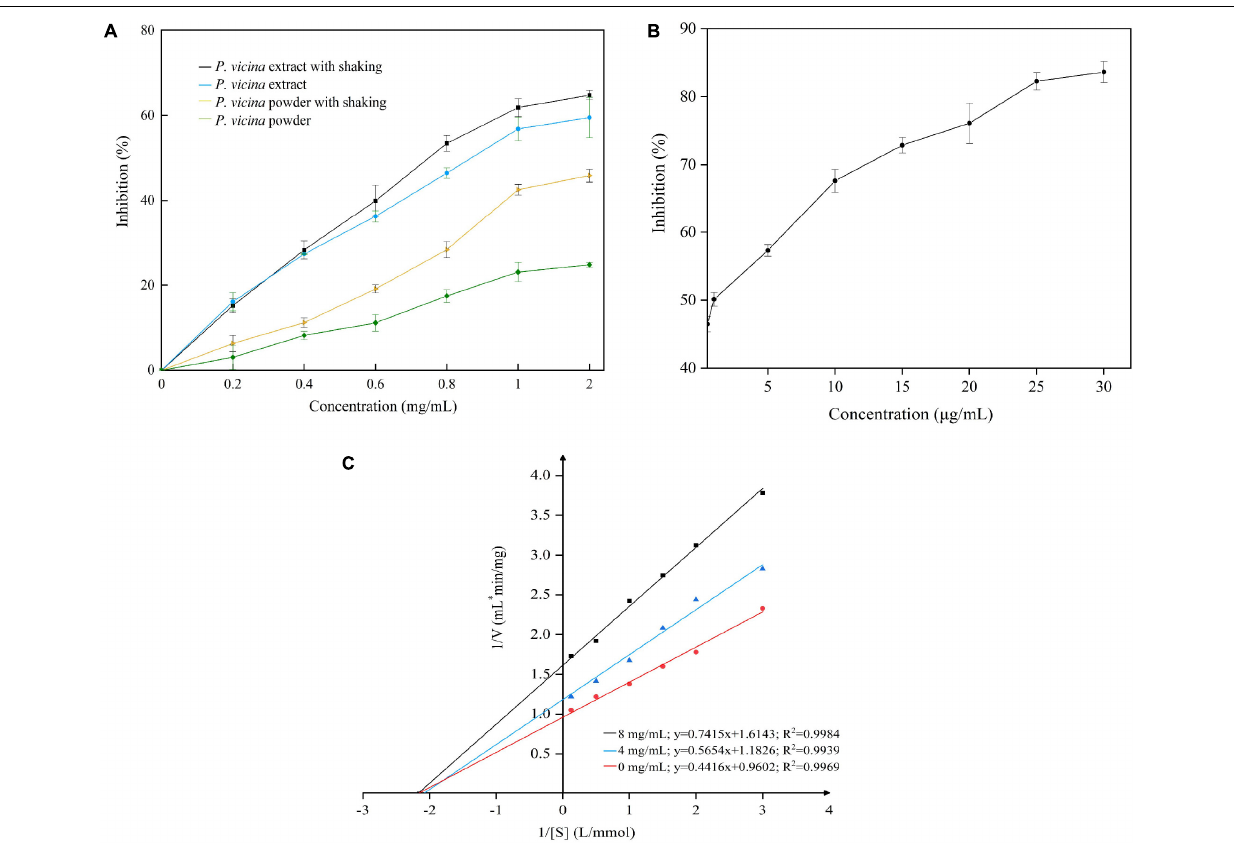
FIGURE 3 | Inhibition of PL by P. vicina extract (A) and orlistat (B , without shaking), and the Lineweaver–Burk plot of the reaction of PL and P. vicina extract (C) .